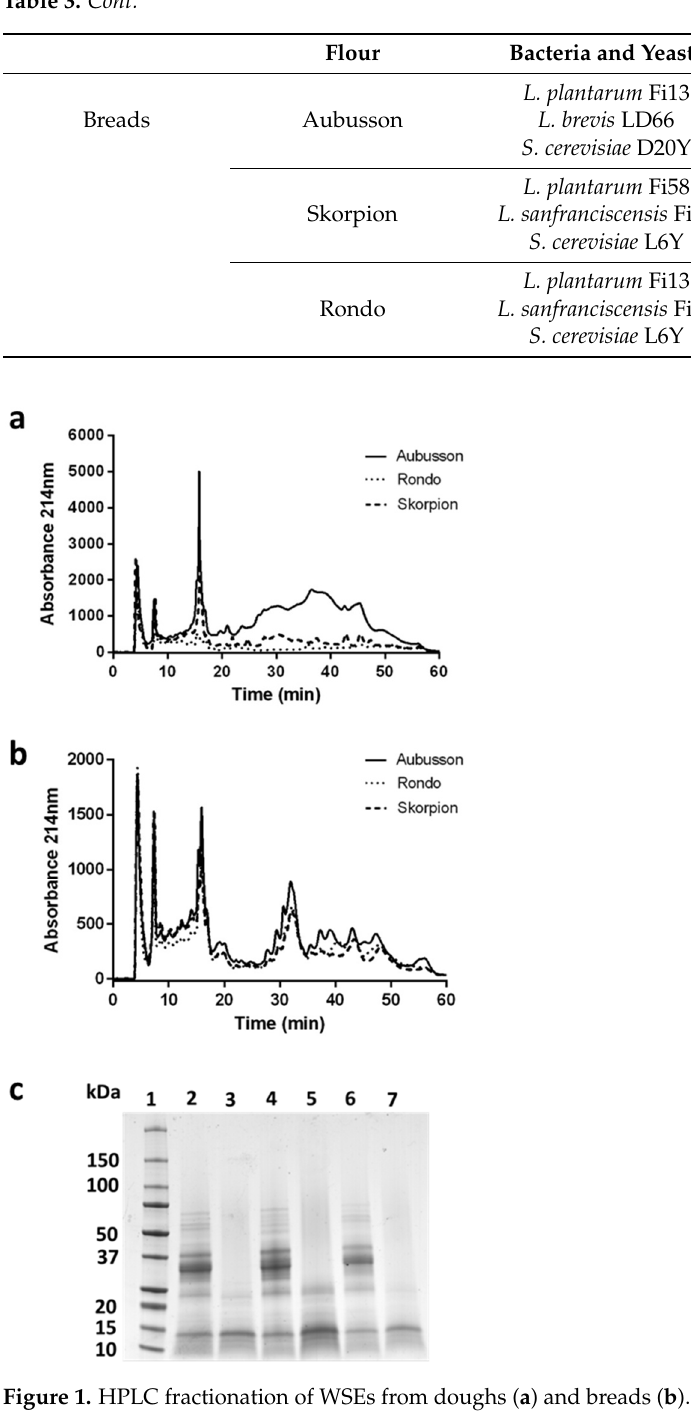
Figure 1. HPLC fractionation of WSEs from doughs ( a ) and breads ( b ). First, 500- µ L aliquots of each sample (Aubusson, Skorpion Rondo) were applied on a reverse phase column (Vydac, 4.6 × 250 mm; 5 µ m; 300 Å) and eluted with a non-linear gradient (Solvent A: H 2 O + 10 mM TFA; Solvent B: CH 3 CN + 10 mM TFA. Gradient: 0–10 min 30%B, 10–50 min 50%B, 50–60 min 100%B). ( c ) SDS-PAGE analysis of extracts and peptides from breads. 1 Bio-rad All Blue Standard; 2 Aubusson; 3 Aubusson 5–20 min; 4 Rondo; 5 Rondo 5–20 min; 6 Skorpion; 7 Skorpion 5–20 min.